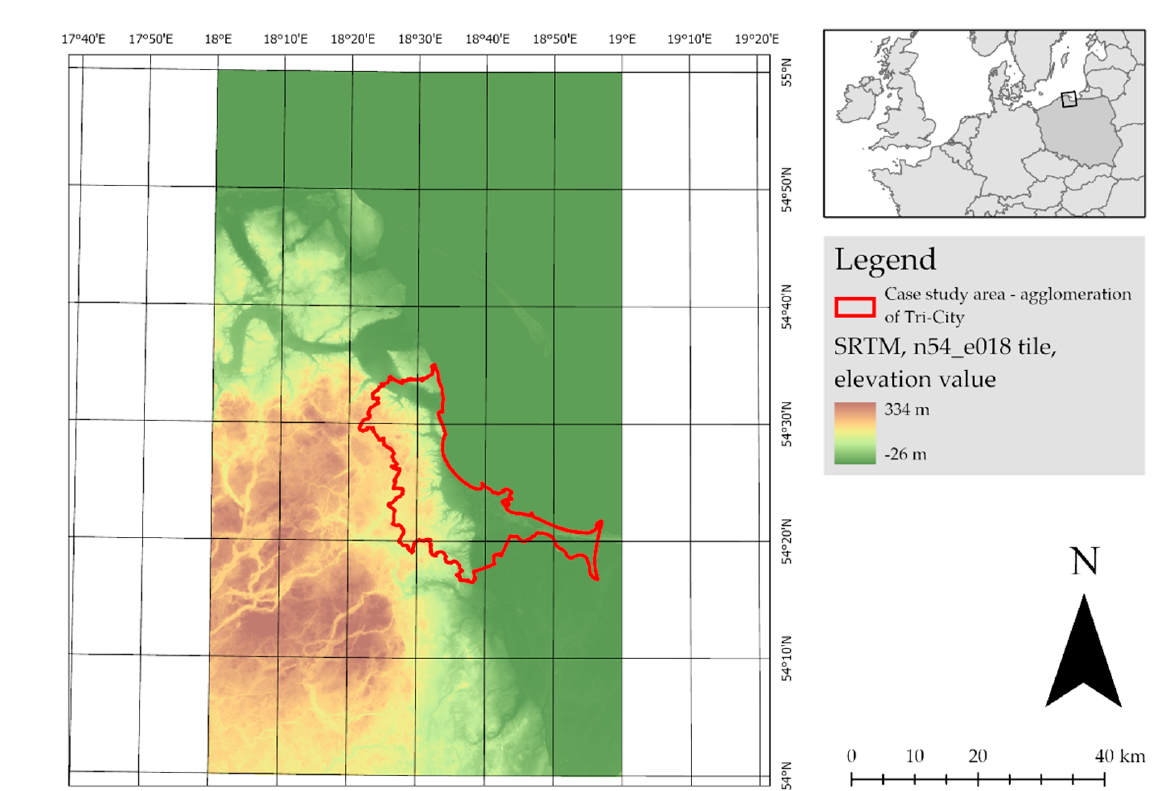
Figure 6. SRTM, n54_e018 tile. Source: own elaboration, on the basis of USGS [54].